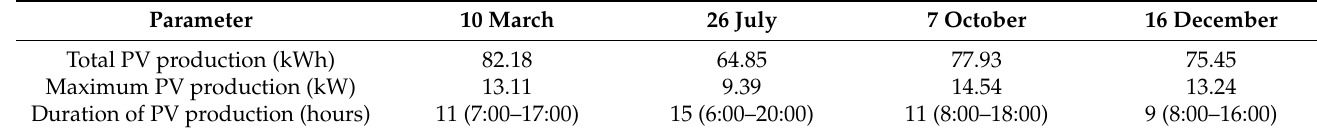
Table 3. PV production boundaries.